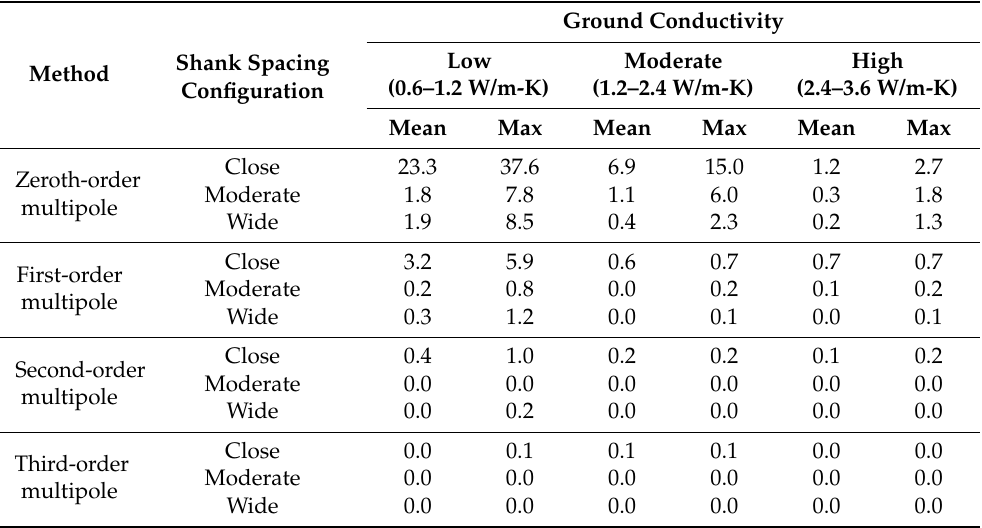
Table 3. Mean and maximum absolute percentage errors in calculation of the total internal thermal resistance ( R a ) for the 216 cases provided by